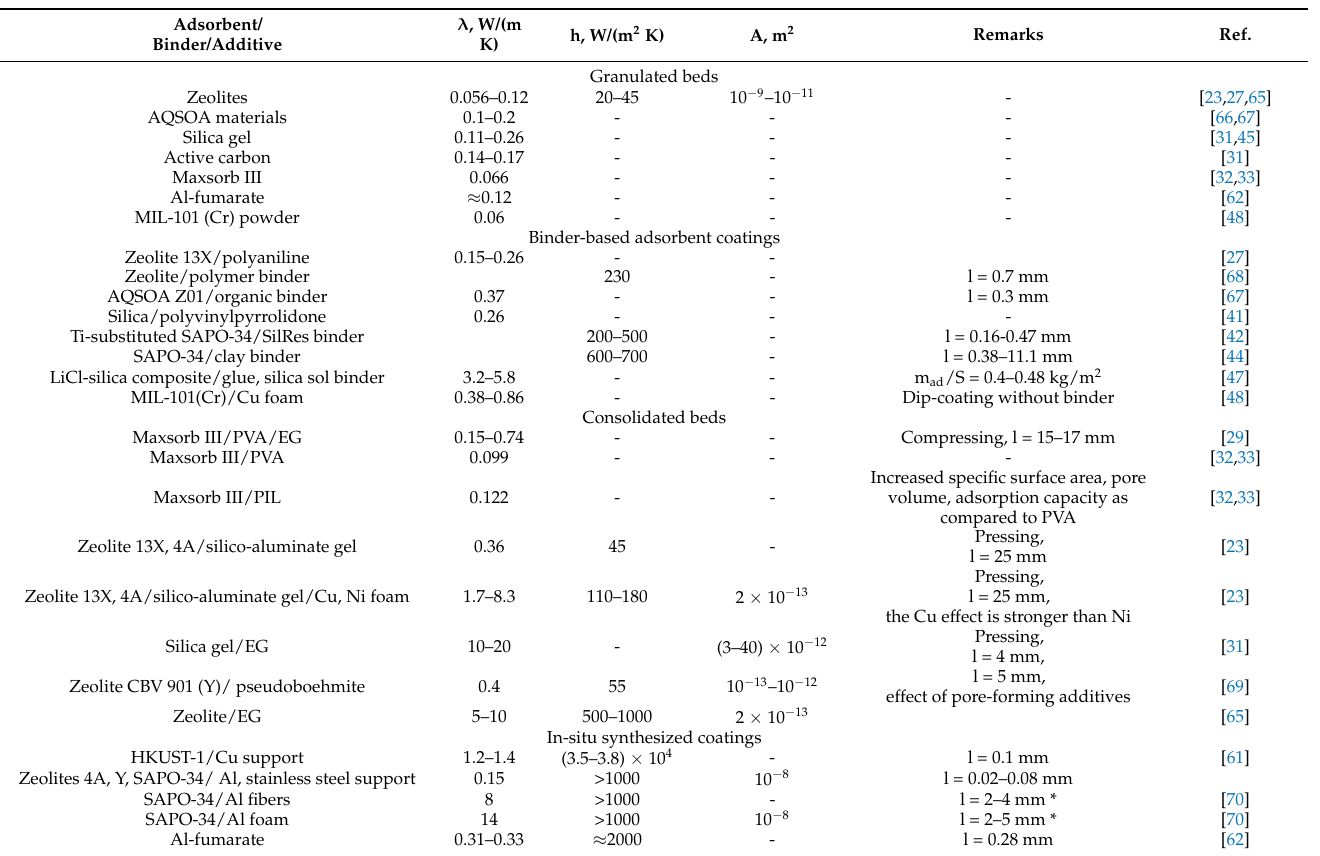
Table 1. Characteristics of HMT for different adsorbent beds. Thermal conductivity ( λ ), wall heat transfer coefficient (h), gas permeability (A), thickness